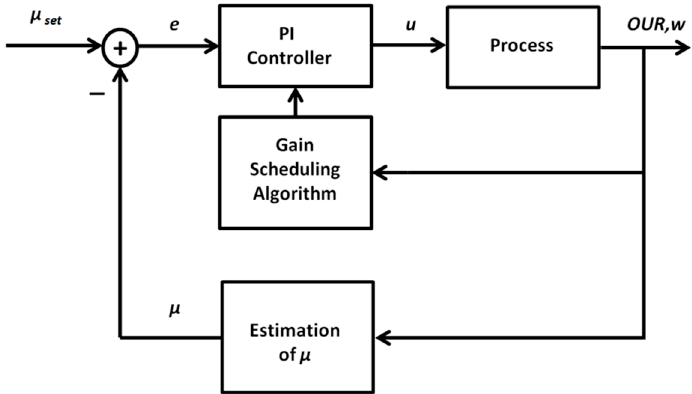
Figure 3. General structure of the adaptive proportional–integral–derivative (PID) control system for specific growth rate control.